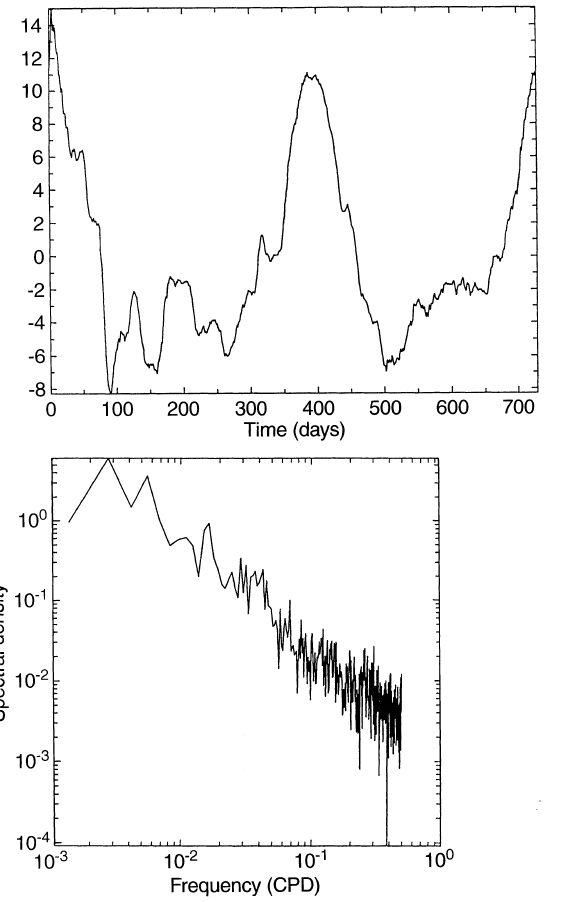
Fig. 15. Top : evolution of the sea-level at [26 (cid:176) W, 35 (cid:176) N] over the two years of simulation (cm); bottom : spectral density of this evolution